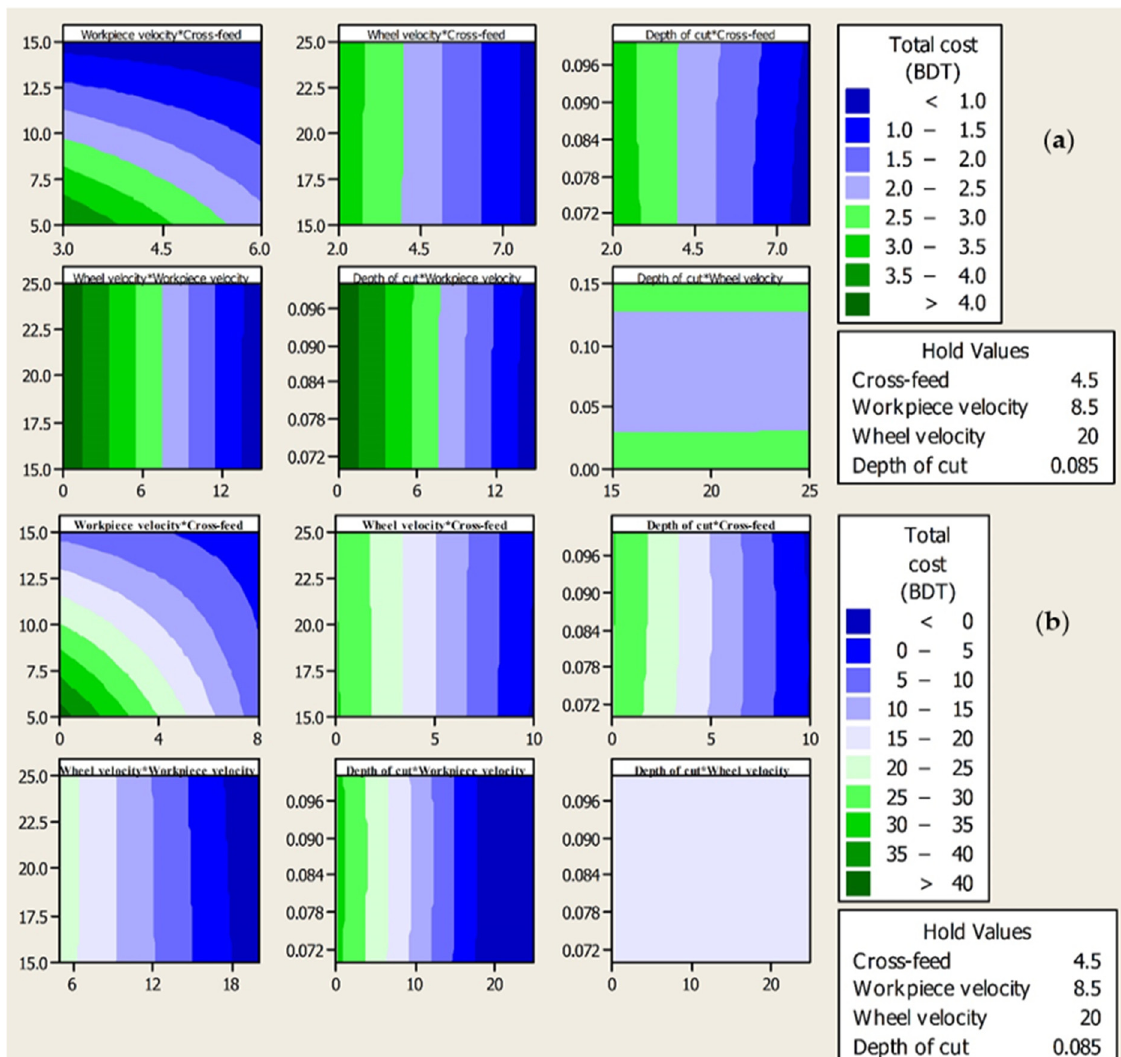
Figure 7. Contour plot of the total cost for each combination of input parameters. ( a ) Surface grinding under dry condition and ( b ) surface grinding under wet condition. Table 5. Optimum range of input parameters from RSM.